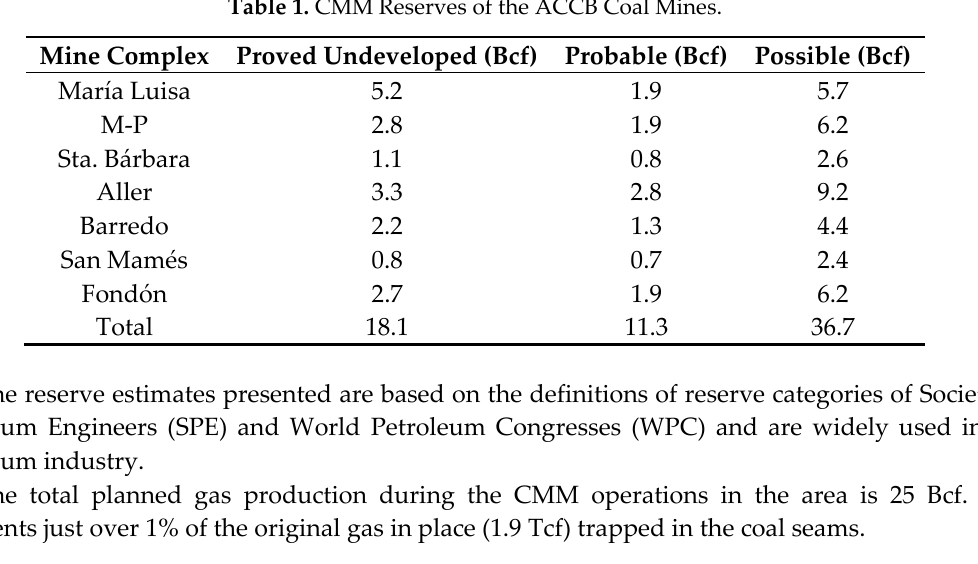
Table 1. CMM Reserves of the ACCB Coal